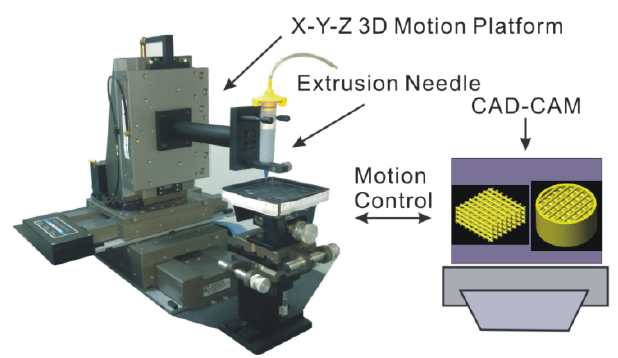
Figure 1. Experimental set-up for the direct write printing